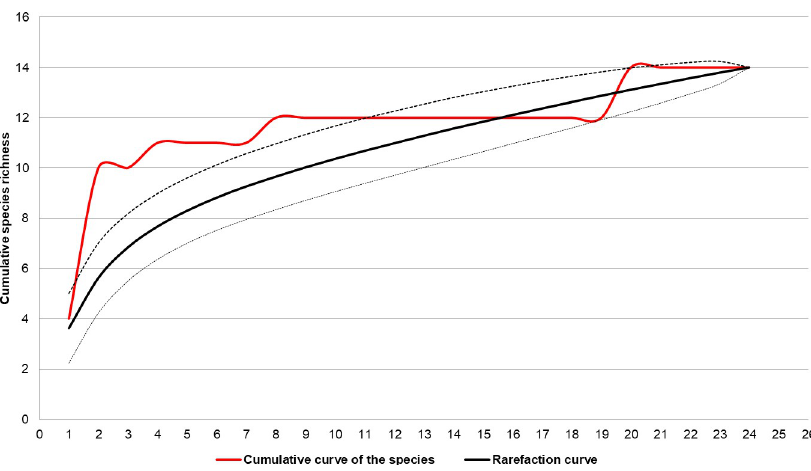
Fig 10. Cumulative curve of sandfly species in forested, rural, and urban areas (solid red line), 95% confidence intervals (dashed lines), and rarefaction curve (solid black line). Corumba´, Mato Grosso do Sul, Brazil. May 2015 to April